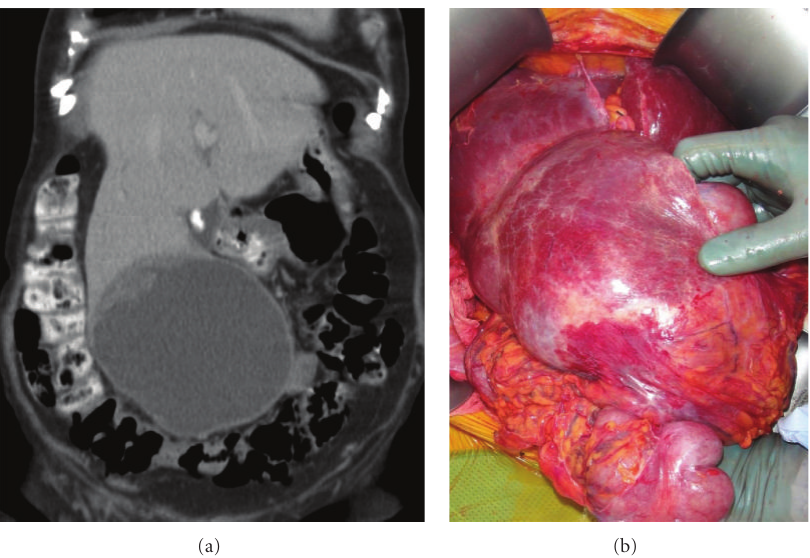
Figure 1: (a) Coronal computed tomography imaging demonstrating cystic tumour within the liver with more peripheral solid component.